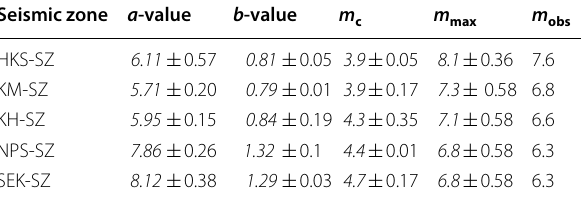
Bozorgnia (2008) and Sharma et al. (2009) were used. In general, the GMPEs developed for regions with tectoni- cally active shallow crust show conformity (Nath and Thingbaijam 2011). The equations of Boore and Atkin- son (2008) and Campbell and Bozorgnia (2008) were developed for areas with active tectonic setup using the PEER NGA (Pacific Earthquake Engineering Research Center’s Next Generation Attenuation) strong motion database, whereas Sharma et al. (2009) used seismic data from Indian Himalaya and Zagros region of Iran. Boore and Atkinson’s (2008) GMPE is for average-horizontal ground motions as a function of moment magnitude ( M w ), closest horizontal distance from the source to site ( R JB ), local average shear-wave velocity up to 30 m ( V s 30), and type of the fault. Campbell and Bozorgnia (2008) model estimates PGA, PGV (peak ground velocity), PGD (peak ground displacement) and linear response spectra ( T 0.01–10 s) for shallow continental earthquakes for = western North America and similar tectonic regimes. The variables of this GMPE are magnitude, closest distance to co-seismic rupture, style-of-faulting, hanging-wall effects and shallow linear and non-linear shear-wave veloc- ity of the site. Finally, Sharma et al. (2009) is developed with respect to magnitude, shear-wave velocity site class and the style-of-faulting. These GMPEs have been used in the probabilistic seismic hazard assessment of Hima- laya (Nath and Thingbaijam 2012; Sitharam 2014); also